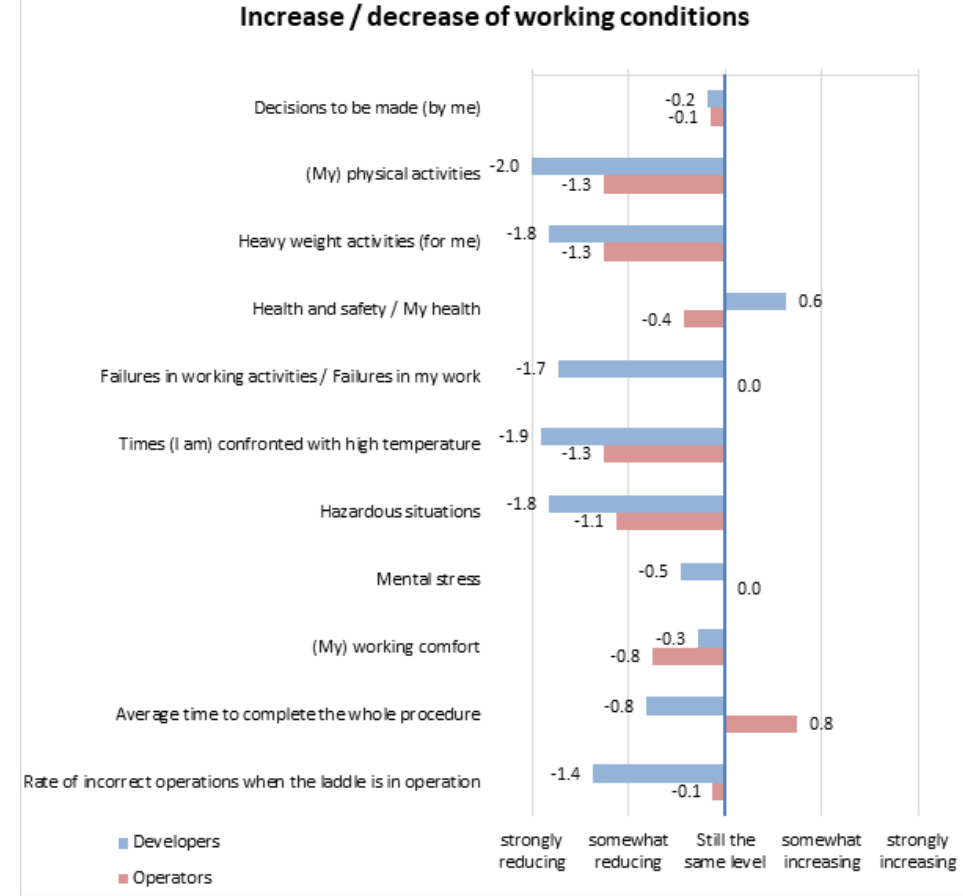
Figure 7. Overview of the perceived impact of the robotic cell on the working conditions. (Average of the answers within a 5-point scale, from −2 strongly and −1 somewhat disagree over 0 do not agree or disagree to +1 somewhat agree to +2 strongly agree)